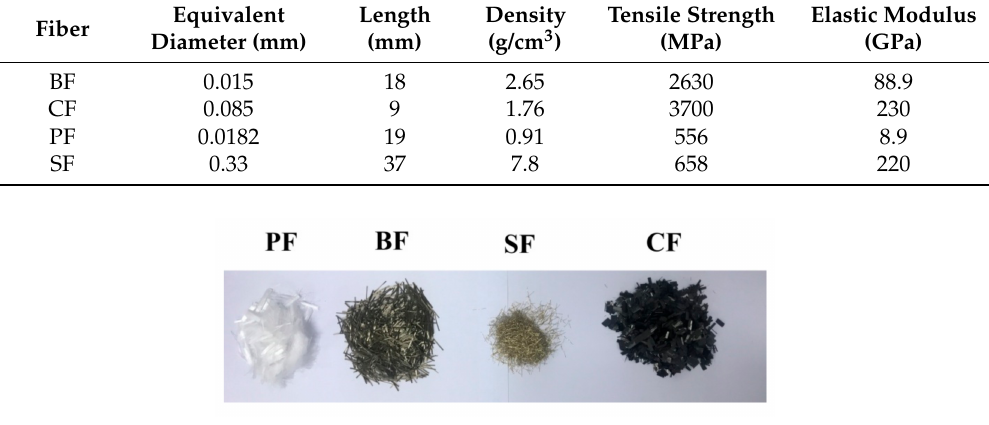
Figure 1. Fibers for recycled aggregate concrete.